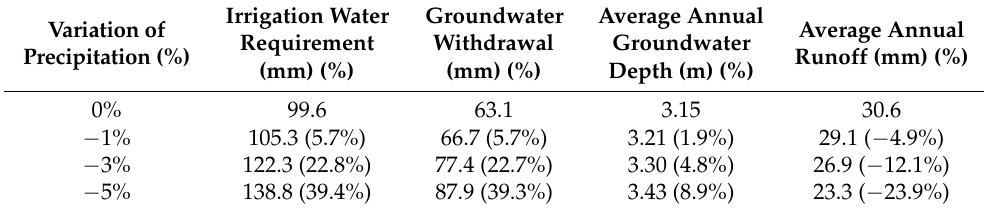
Table 5. Effects of precipitation variability on irrigation, streamflow, and the groundwater